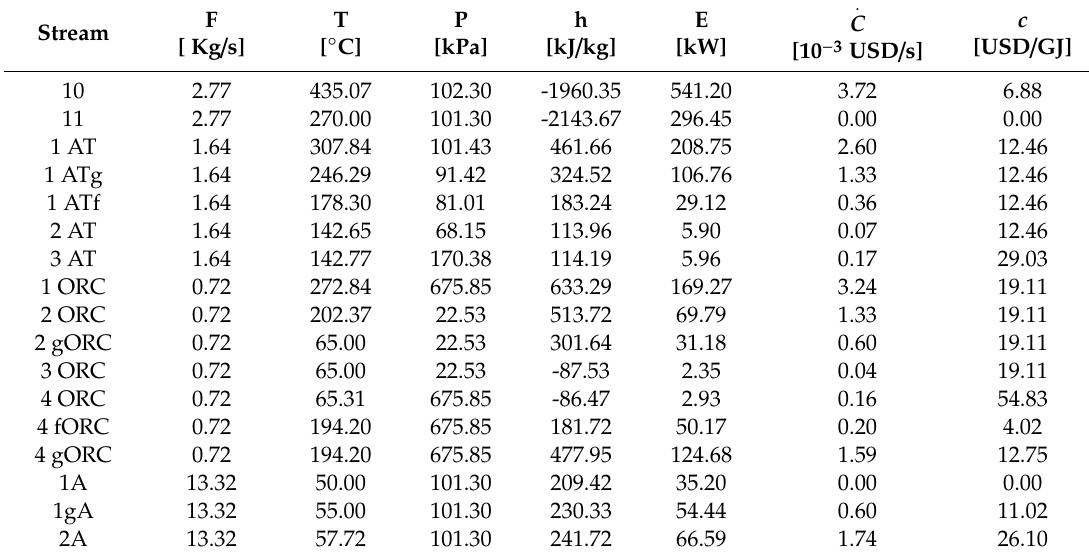
Table A1. Thermodynamic properties and cost rate at di ff erent point using Toluene.